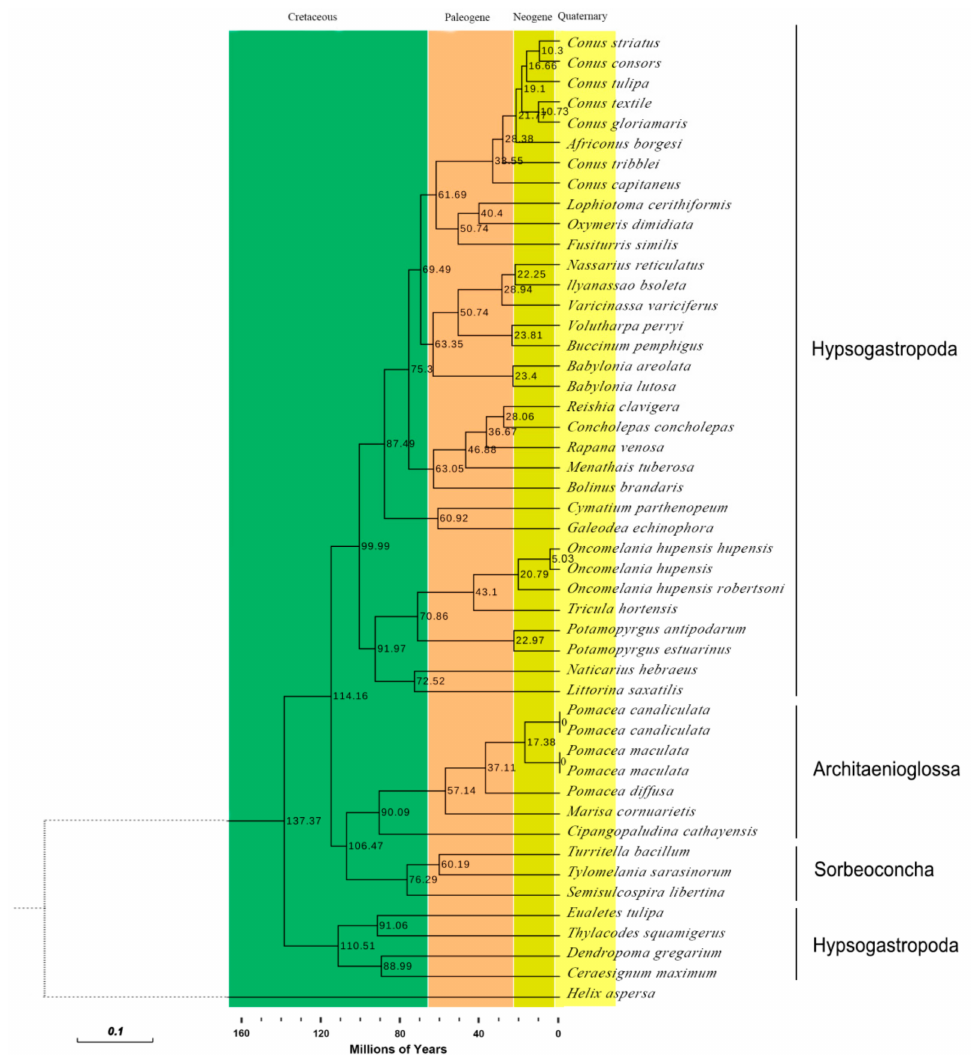
Figure 9. Chronogram for the 47 species of Caenogastropoda with a single out-group ( Helix aspersa , NC_021747) based on the Bayesian topology calculated from analysis of the 13 PCGs. Divergence times were estimated using three calibrations. Numbers near the nodes indicated the average estimated divergence time estimated in